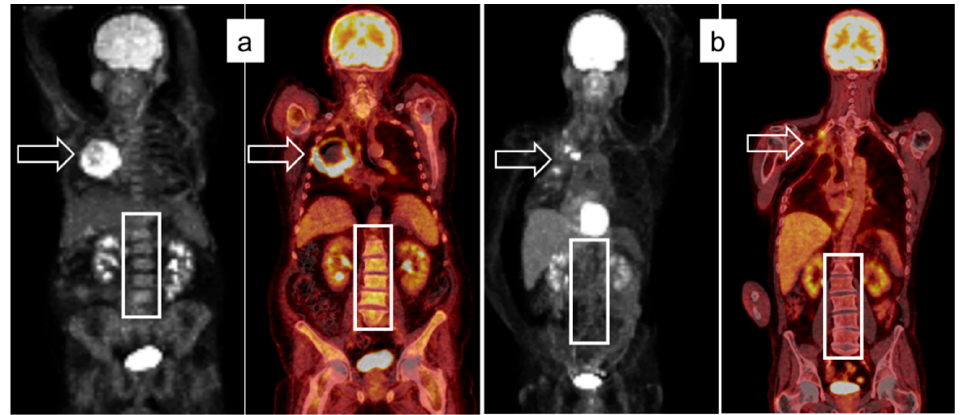
Figure 3. Kaplan–Meier curves for progression-free ( a ) and overall survival ( b ) according to combined MTV and BLR subgroups. MTV = metabolic tumor volume, BLR = bone marrow to liver ratio.